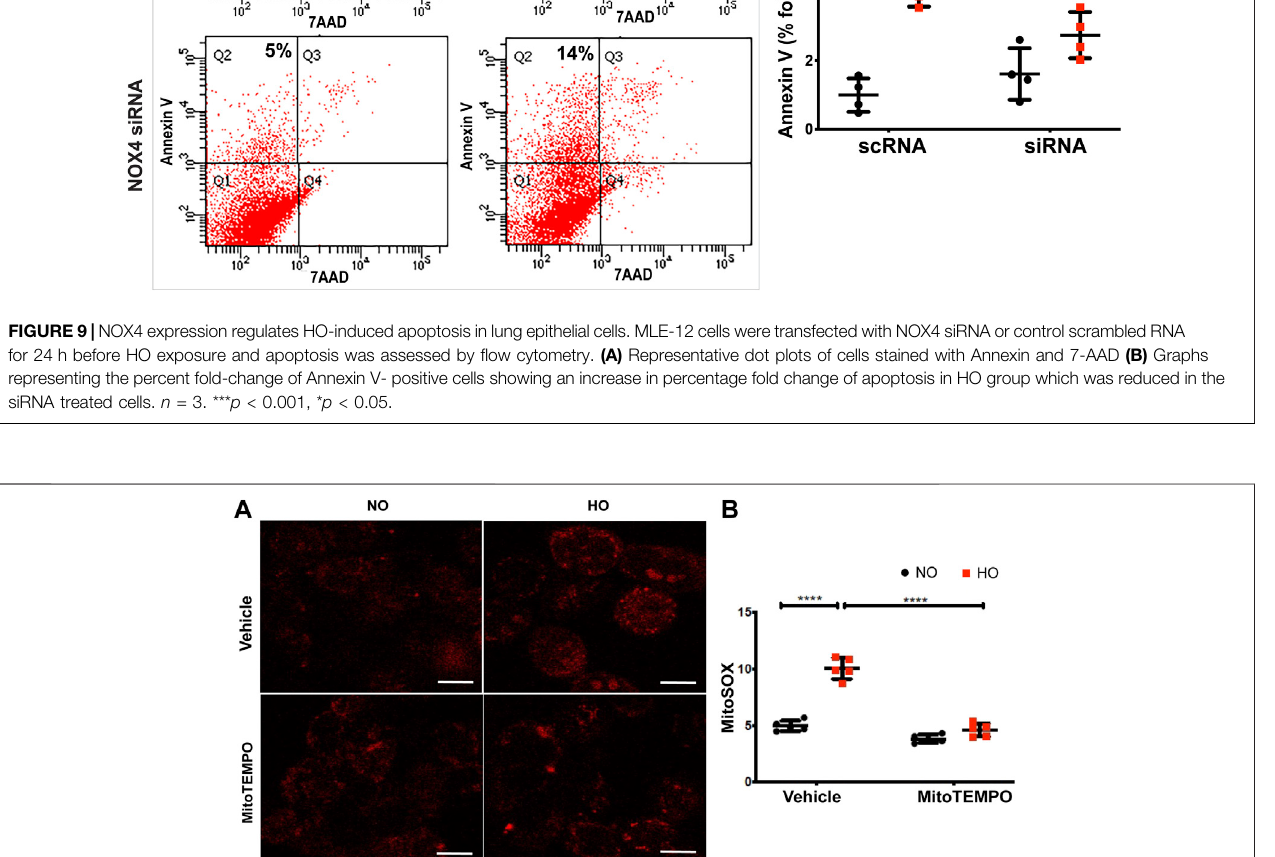
FIGURE10| HO-induced ROSgeneration inMLE-12 cells isattenuated byMitoTEMPO.MLE-12 cells werepretreatedwith vehicle or MitoTEMPO (10 µm) for1 h and challenged with HO for 48 h. Mitochondrial superoxide production was assayed by MitoSOX red reagent (5 µm) (A) Representative images of MLE-12 cells stained with MitoSOX and (B) Quanti fi ed fl uorescence intensity measured as arbitrary units showed an increase in MitoSOX staining with HO and decrease with MitoTEMPO treatment. n = 3. **** p <